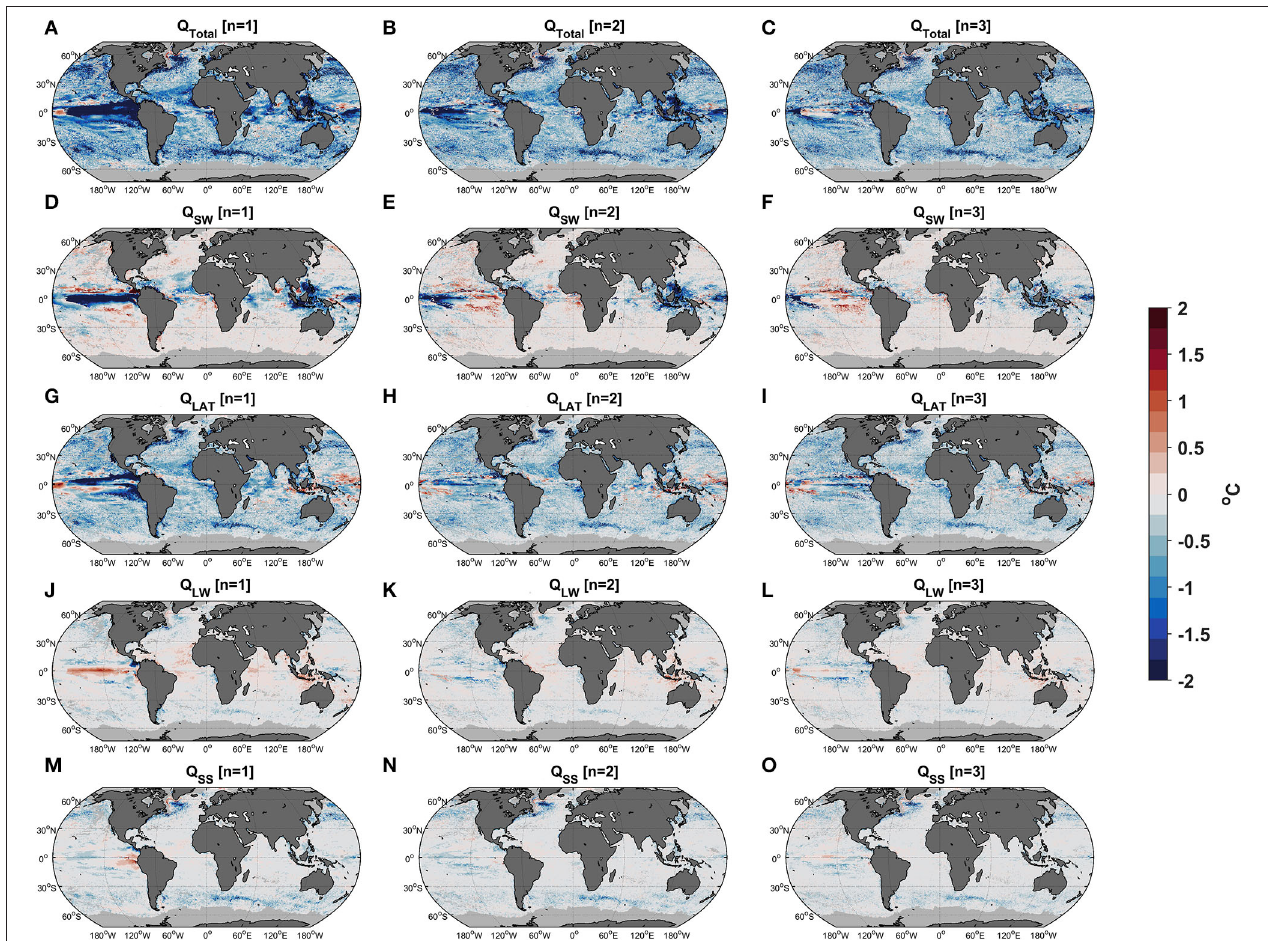
FIGURE 8 | The structure of the figure is the same as Figure 7 where the labeling is explained. Grid points where decay periods ended after Dec-31st 2014, or contaminated by sea-ice, were excluded from the analysis (gray